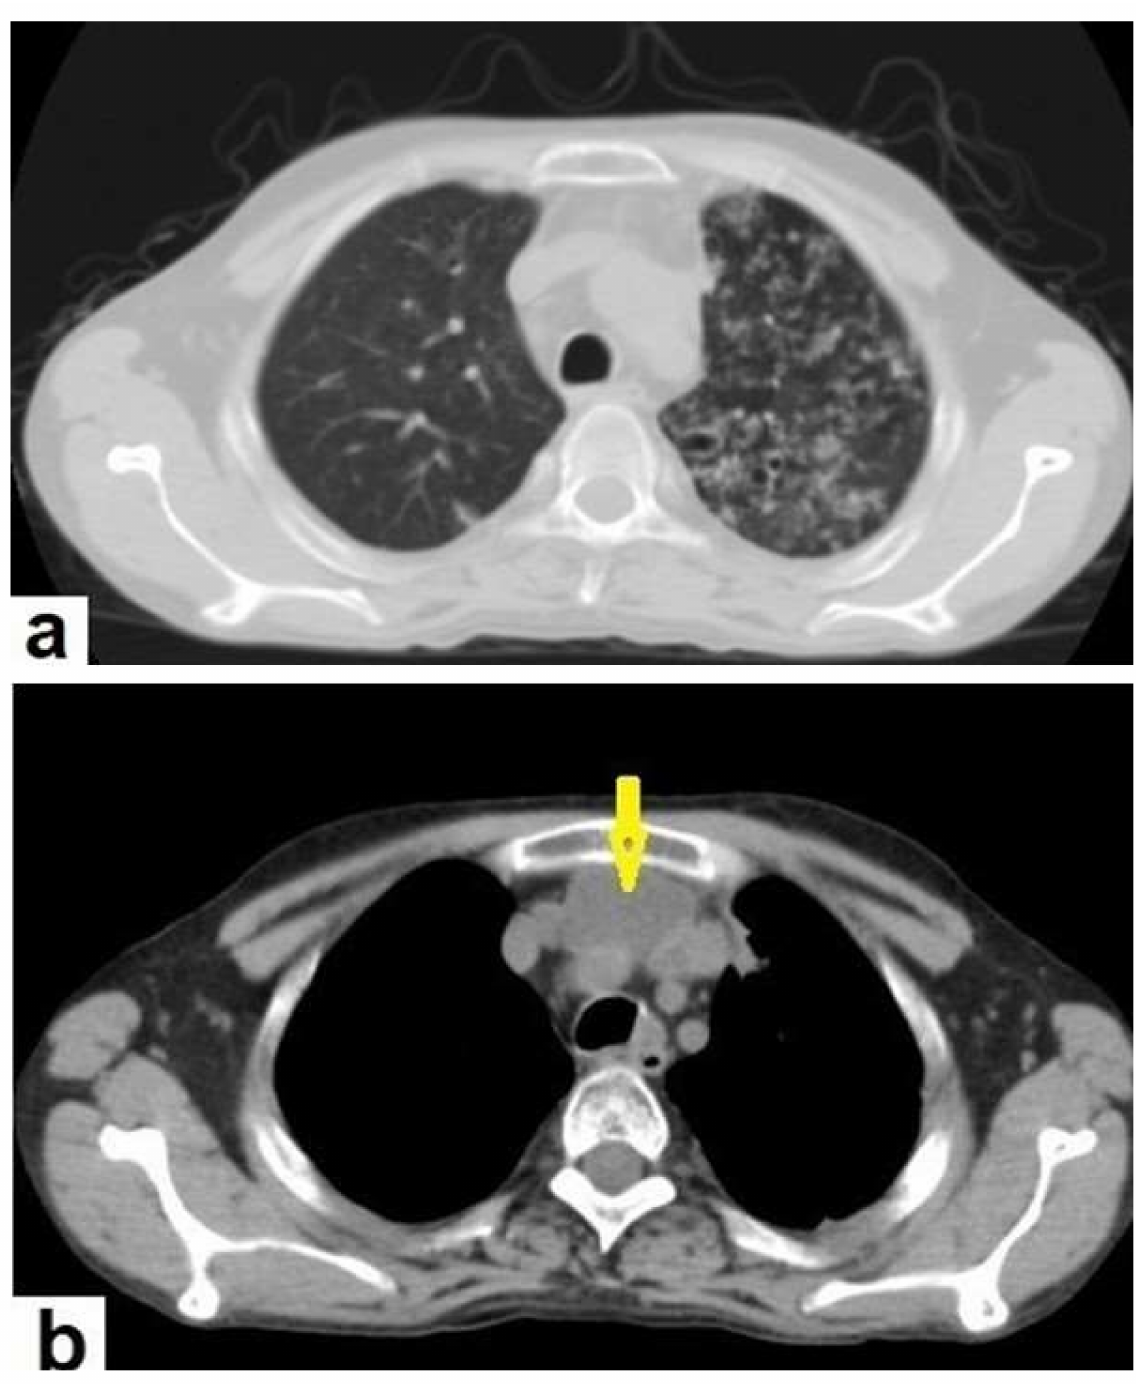
Figure 5. Active TB in a 27-year-old man (same case of Figure 2) with endobronchial spread. ( a ) Axial image of chest CT shows endobronchial spread characterized centrilobular and tree-in-bud nodules involved the upper lobe of the left lung. ( b ) CT axial image with mediastinal window shows large necrotic mediastinal lymph node measures 21 mm × 20 mm (arrow) in the anterior